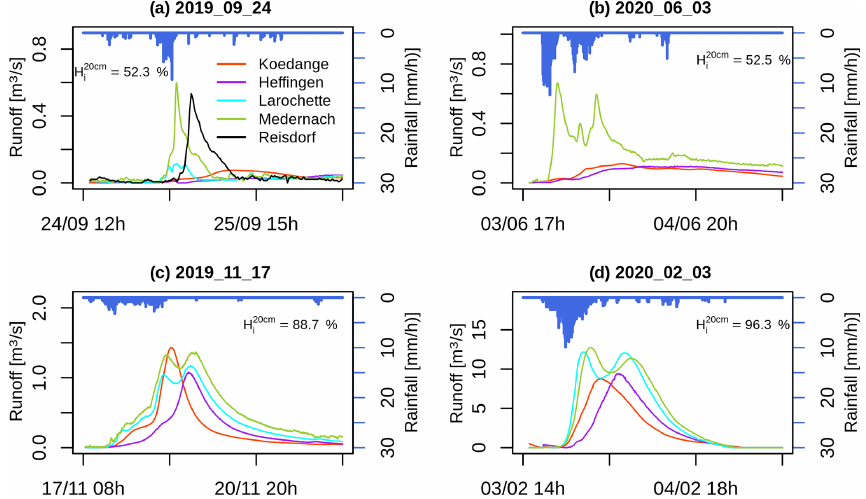
Figure 5. Four rainfall–runoff events that have occurred in the Ernz Blanche catchment with different soil moisture conditions. Rainfall amounts are calculated for the Ernz Blanche catchment at Medernach (79km 2 ). The runoff time series are observed at Koedange (31.1km 2 orange), Heffingen (48.8km 2 , purple), Larochette (69.4km 2 , cyan), Medernach (79km 2 , green), and Reisdorf (100.6km 2 , black). H 20cm corresponds to the soil moisture conditions observed at 20cm in depth before each event. Note that scales for discharge time series are different on each